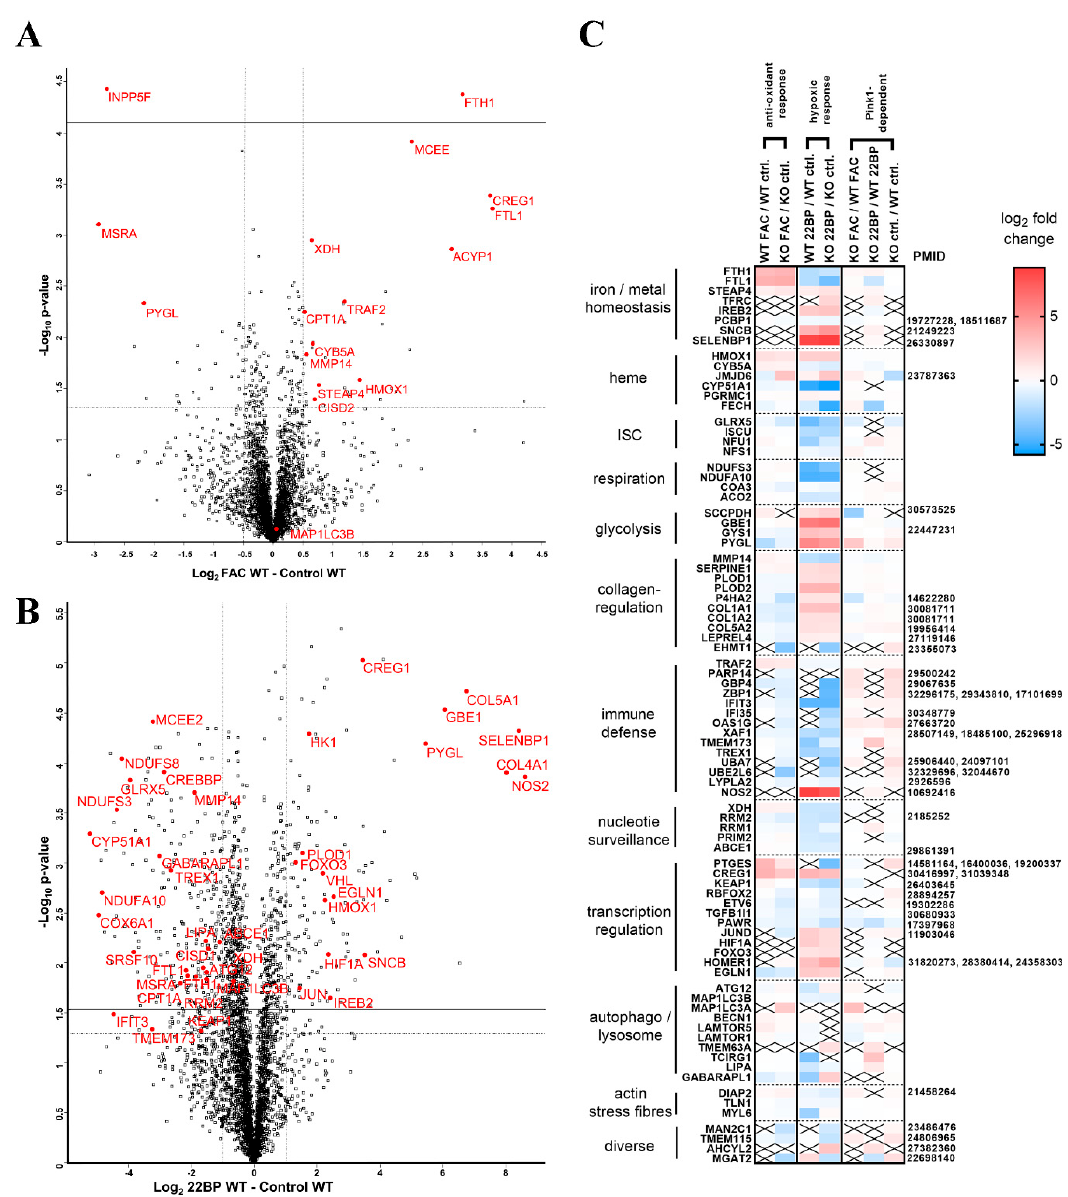
Figure 2. Global proteome profiles presented as Volcano plots, where significance ( − log 10 p -value) is shown on the Y-axis (actual threshold visualized by a solid line (FDR = 0.05), nominal threshold by a dotted line, p = 0.05), while fold-changes (log 2 differences) are presented on the X-axis (dotted line refers to cuto ff used for subsequent Search Tool for the Retrieval of Interacting Genes / Proteins (STRING) interaction and pathway enrichment analyses). Gene symbols were used to identify relevant